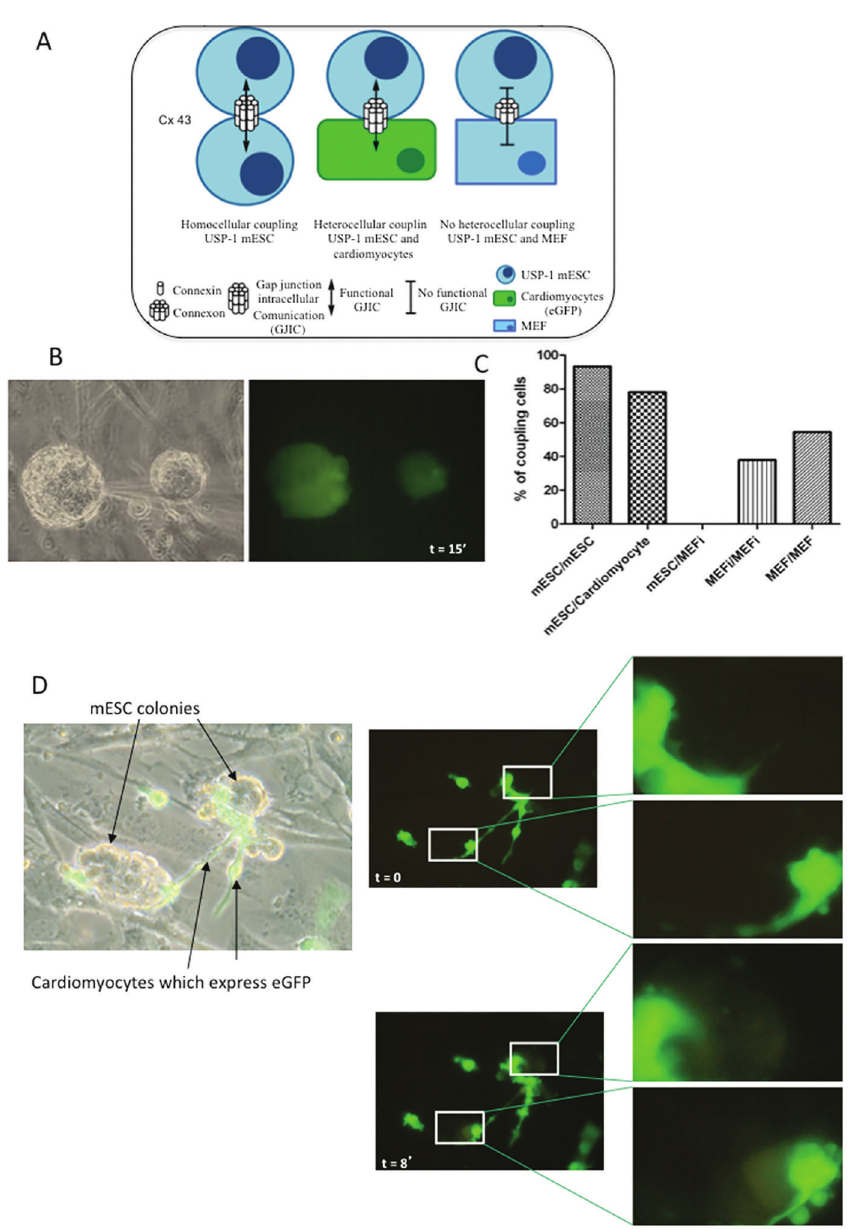
Figure 4 - Presence of functional coupling among undifferentiated mESC and cardiac cells. Dye coupling was assayed through intracellular injection of Lucifer Yellow (LY) by hyperpolarizing currents pulses. A: illustration summarizes the possible couplings investigated with mESC; B: a representative figure of two colonies injected with LY; phase contrast (left) and Fluorescence (right) show that the dye spreads to the whole colony (original magnification 320X); C: the bar graphs summarize the data of cellular coupling analyzed; D: co-culture model of mESC and cardiomyocyte GFP + . Phase contrast and fluorescence of GFP + merged images (left). Functional hetero-cellular coupling. In the middle, the pictures show two different times of dye injection, just before injection (t=0) and 8 minutes after dye injection, and on the right, details of coupling among cardiomyocytes and mESC (original magnification